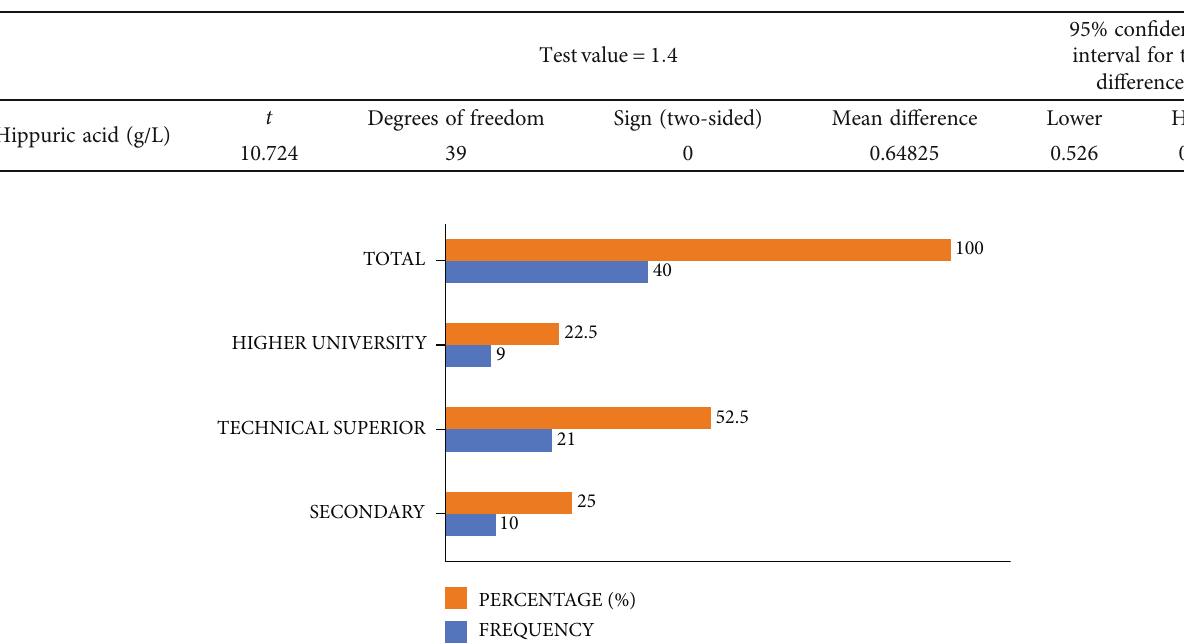
Figure 2: The results (average) of the quanti fi cation of total phenols and hippuric acid in the urine of printing workers ( n = 40 ; gender: male). Table 4: Test for a sample.